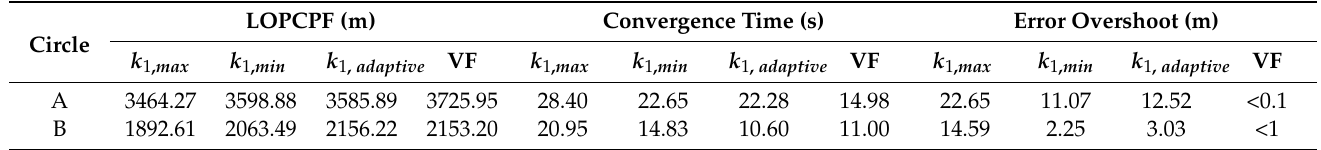
Table 4. The performance comparison of the circular path following using the four